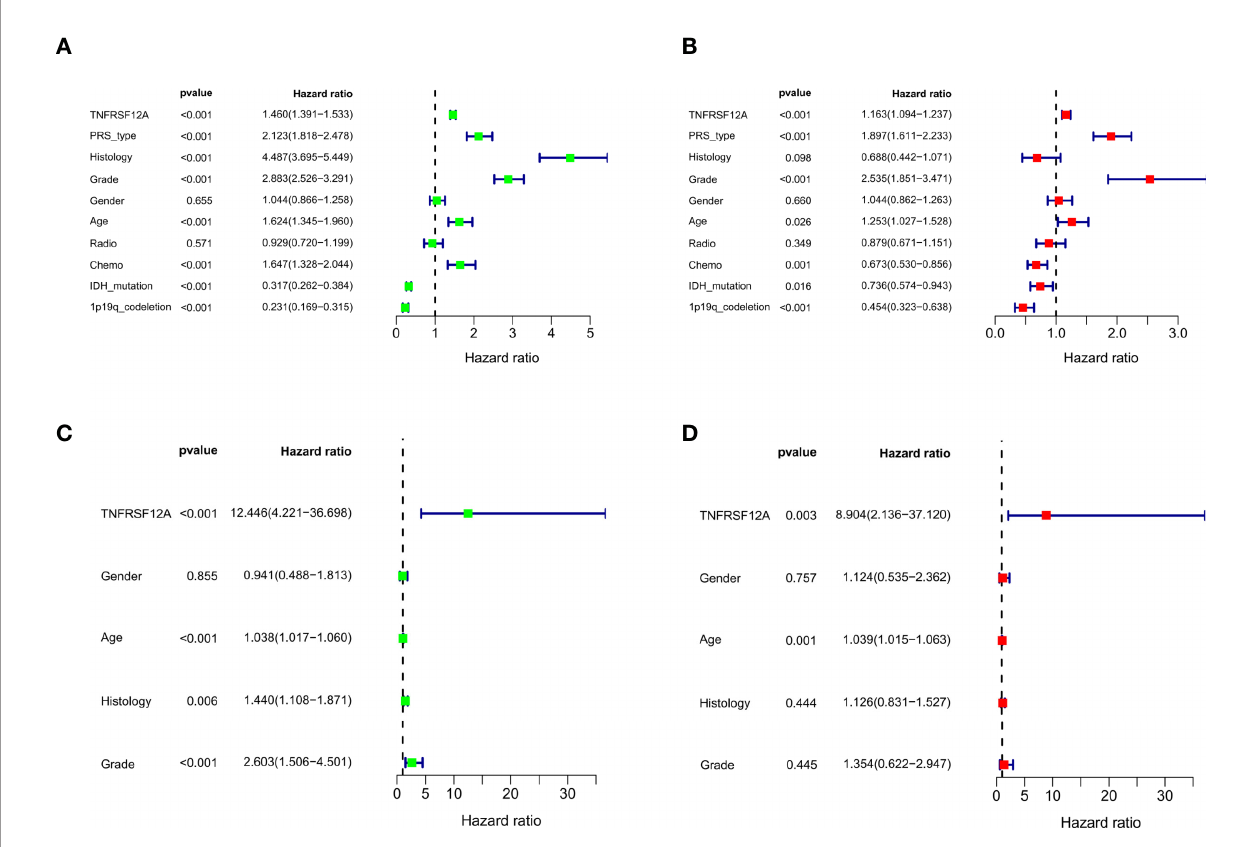
FIGURE 4 | (A) Univariate independent prognostic analysis of samples in CGGA. (B) Multivariate independent prognostic analysis of samples in CGGA. (C) Univariate independent prognostic analysis of samples in GSE43378. (D) Multivariate independent prognostic analysis of samples in